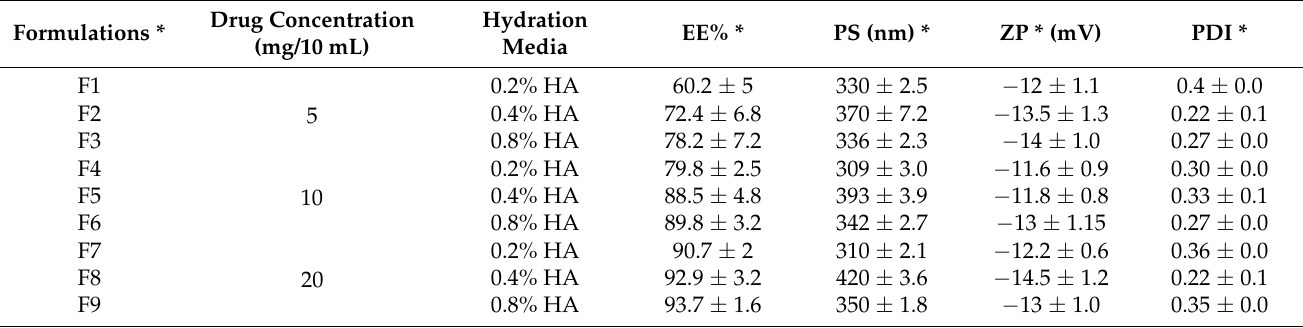
Table 1. Composition of different hyaluosomes